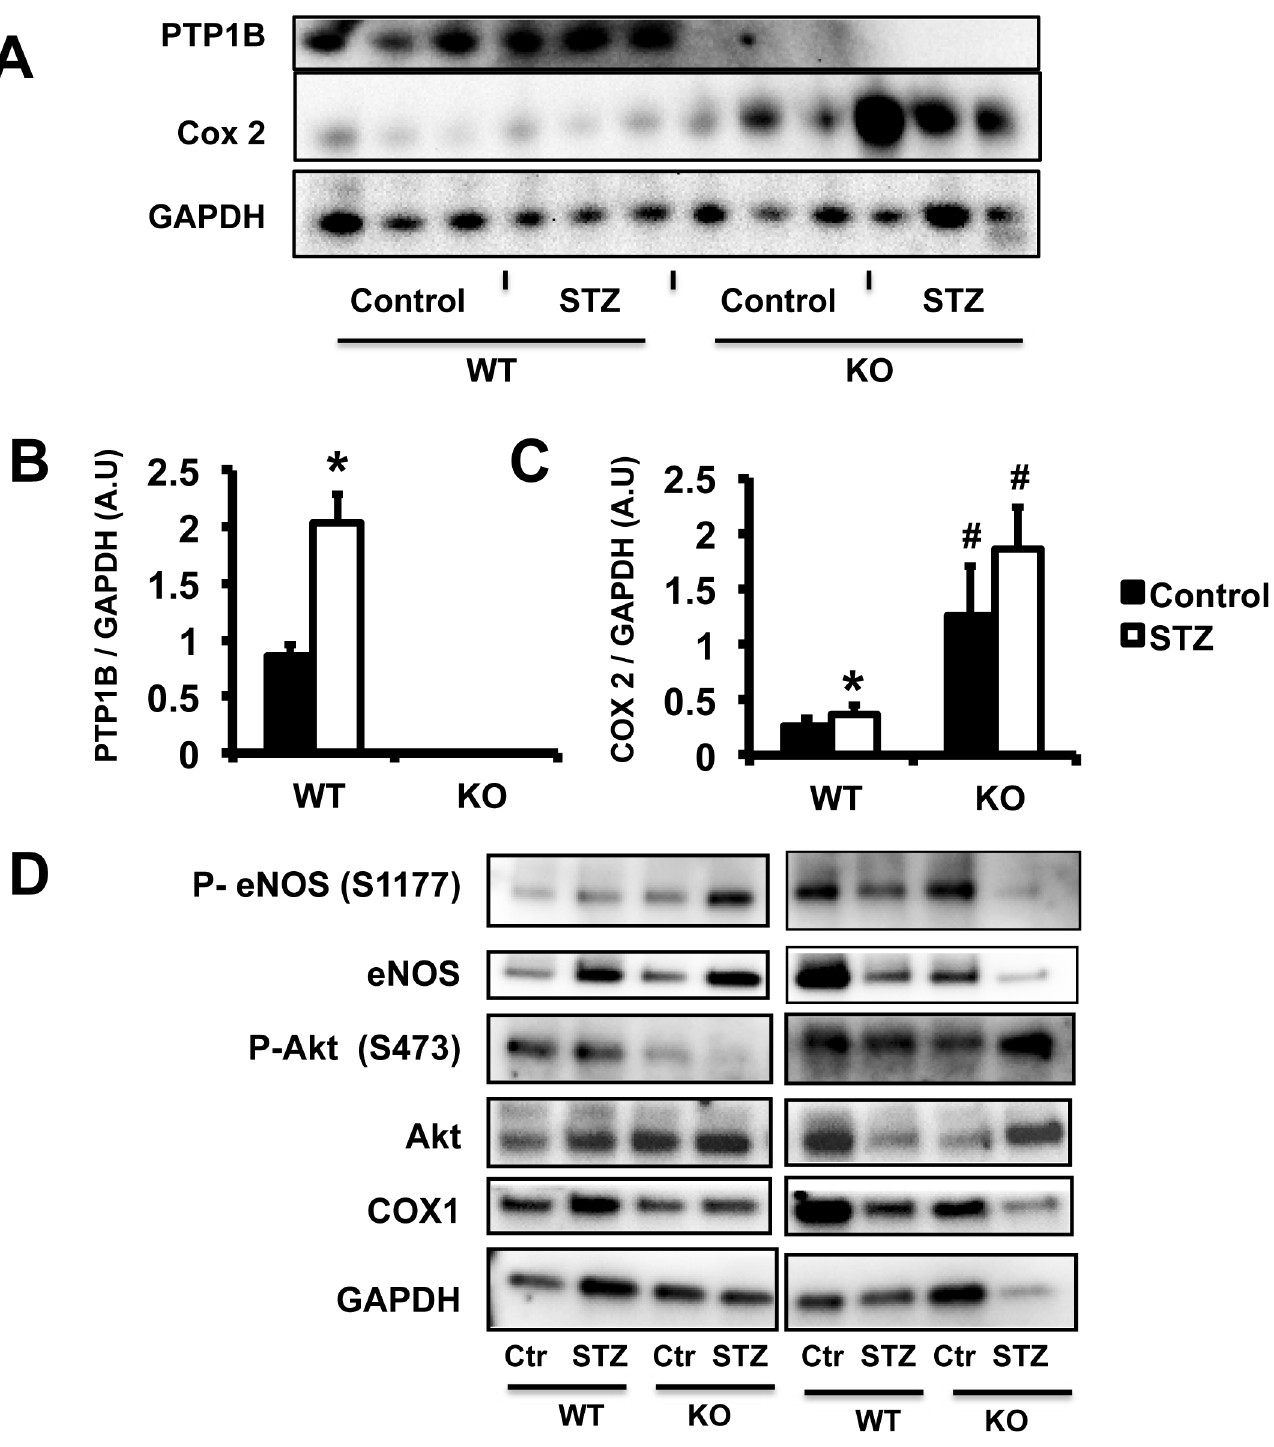
Fig 5. Diabetes increased PTP1B and COX-2 expression in aortic tissue. Quantification of aortic proteins expression via western-blot analysis. A, D: representative picture and B, C: densitometry. Data are mean ± SEM, n = 6 per group. * p < 0.05 vs . Control within the same group, # p < 0.05 vs . WT.